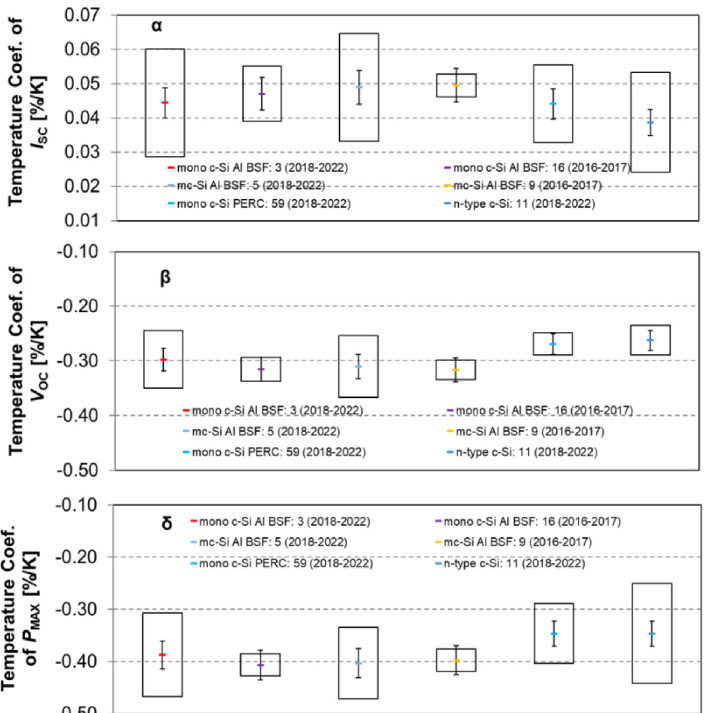
Fig. 4. Temperature coef fi cients of I SC , V OC, and P MAX for different module types. Boxes represent the standard deviation of technology variation ( k =2) and error bars represent the measurement uncertainty ( k =2). Differences overlap with the uncertainty in